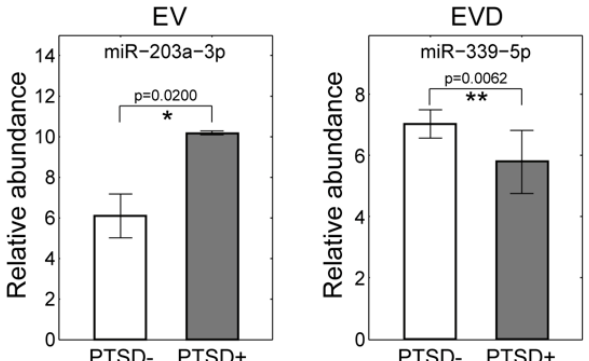
Figure 4. The confirmed differential abundances of miR-203a-3p and miR-339-5p in the independent validation set. The p-values were calculated by unadjusted T-test. * p -value < 0.05; ** p -value < 0.01.